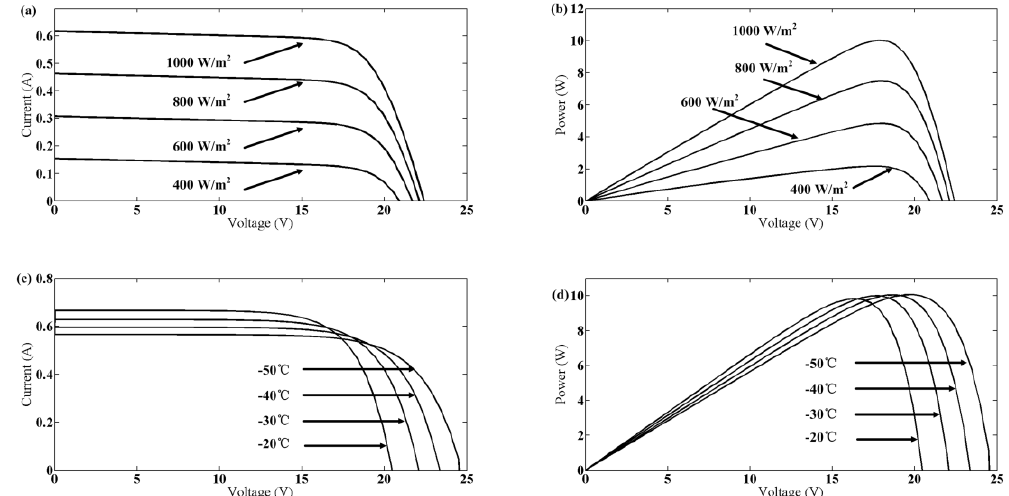
Figure 6. ( a , b ) Output characteristics of PV panel under different radiation intensities at the same temperature (0 °C). ( c , d ) Output characteristics of PV panel under 1000 W/m 2 at different temperatures.